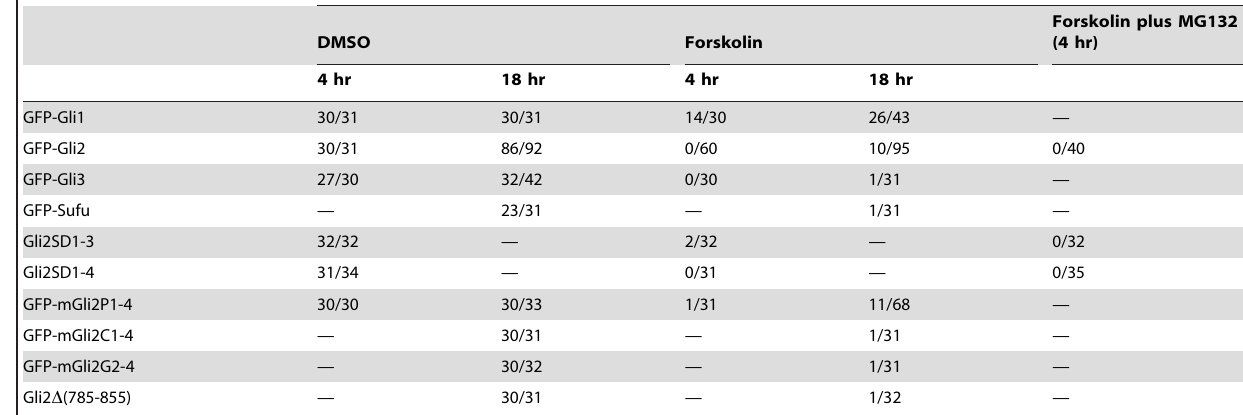
Table 2. The effects of PKA mediated phosphorylation on the ciliary localization of Gli and Sufu proteins.